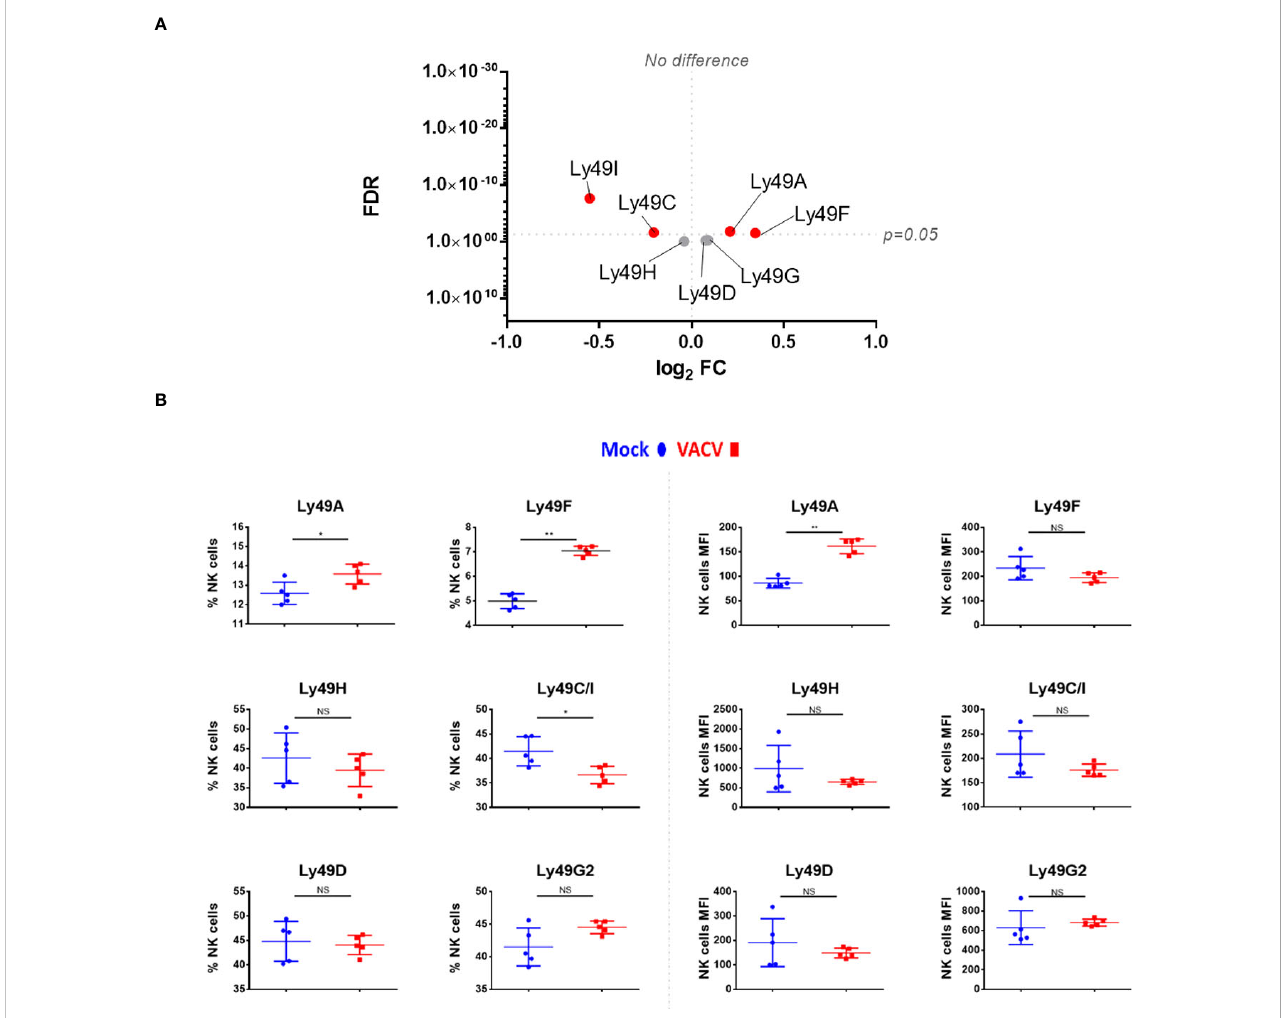
FIGURE 6 Differential expression of Ly49 family receptors at the transcriptional and protein level during VACV infection. (A) C57BL/6 mice ( n =4) were infected with VACV WT or were mock-infected. At 6.5 d.p.i., NK cell transcriptional changes were studied by RNA-seq ( n =4), and differential expression (VACV vs mock) was calculated. Each dot represents the differential expression pro fi le of a Ly49 family transcript (WT vs mock). Red indicates statistical signi fi cance (FDR<0.05). For clarity, the protein name is indicated rather than gene name. (B) Protein expression assessed by FACS for Ly49 receptors in splenic NK cells from mock (blue) and VACV-infected mice (red). The percentage of NK cells expressing the receptor and the MFI for the indicated receptor is shown. Error bars represent ± SD, statistical signi fi cance was assessed with a Mann-Whitney test (*p < 0.05, **p < 0.01). NS, non signi fi